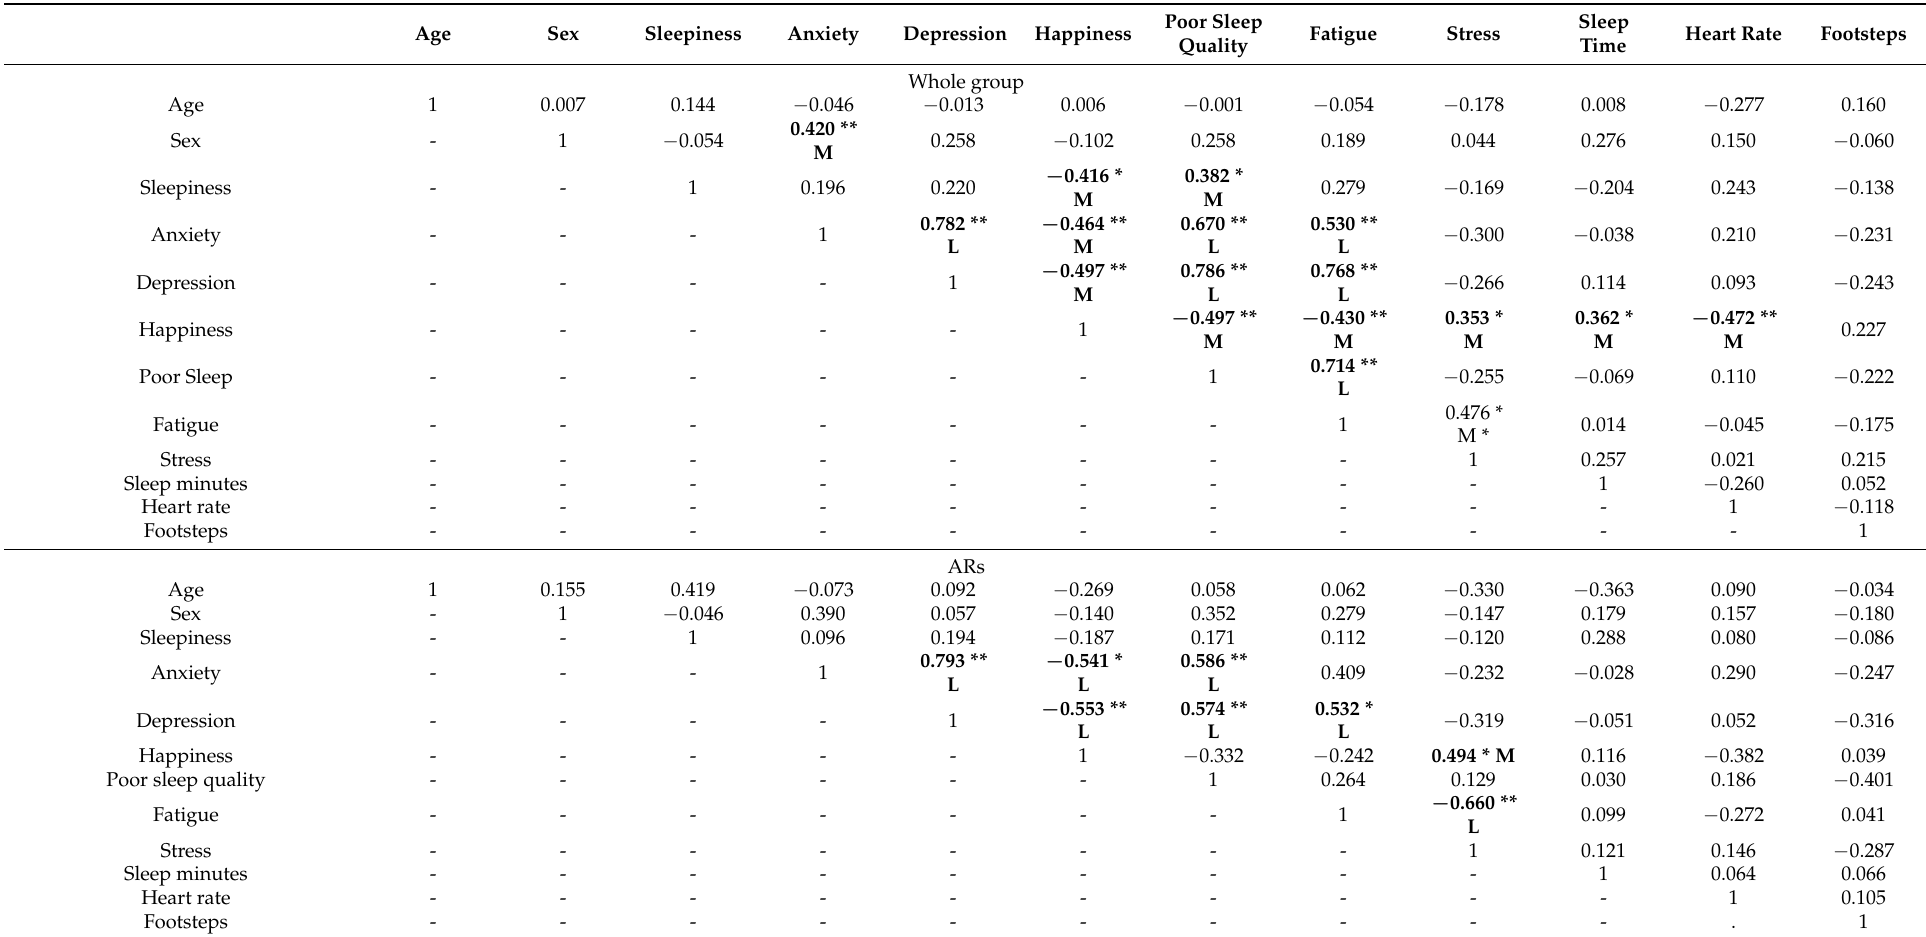
Table 2. Correlation between variables. Pearson coefficient. For statistically significant correlations, the effect size was also